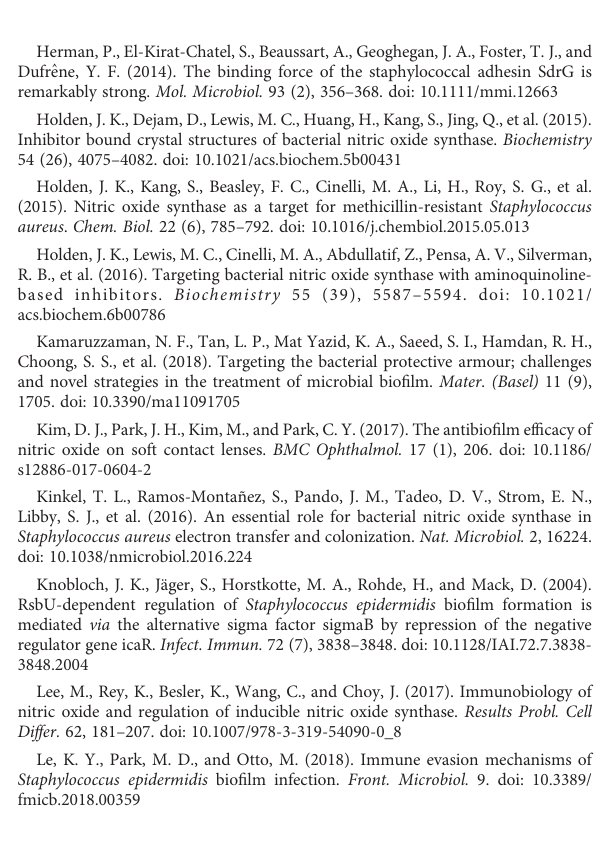
SUPPLEMENTARY FIGURE 1 Schematic map of gene deletion as well as construction and veri fi cation of deletion and complement strains. (A) Schematic diagram for the NOS gene deletion. (B) PCR veri fi cation for the NOS gene deletion. (C) PCR veri fi cation for the construction of the NOS gene complement strain. SE1457 , SE1457- D NOS and SE1457- D NOS:cNOS are the wild strain, deletion strain and complement strain,